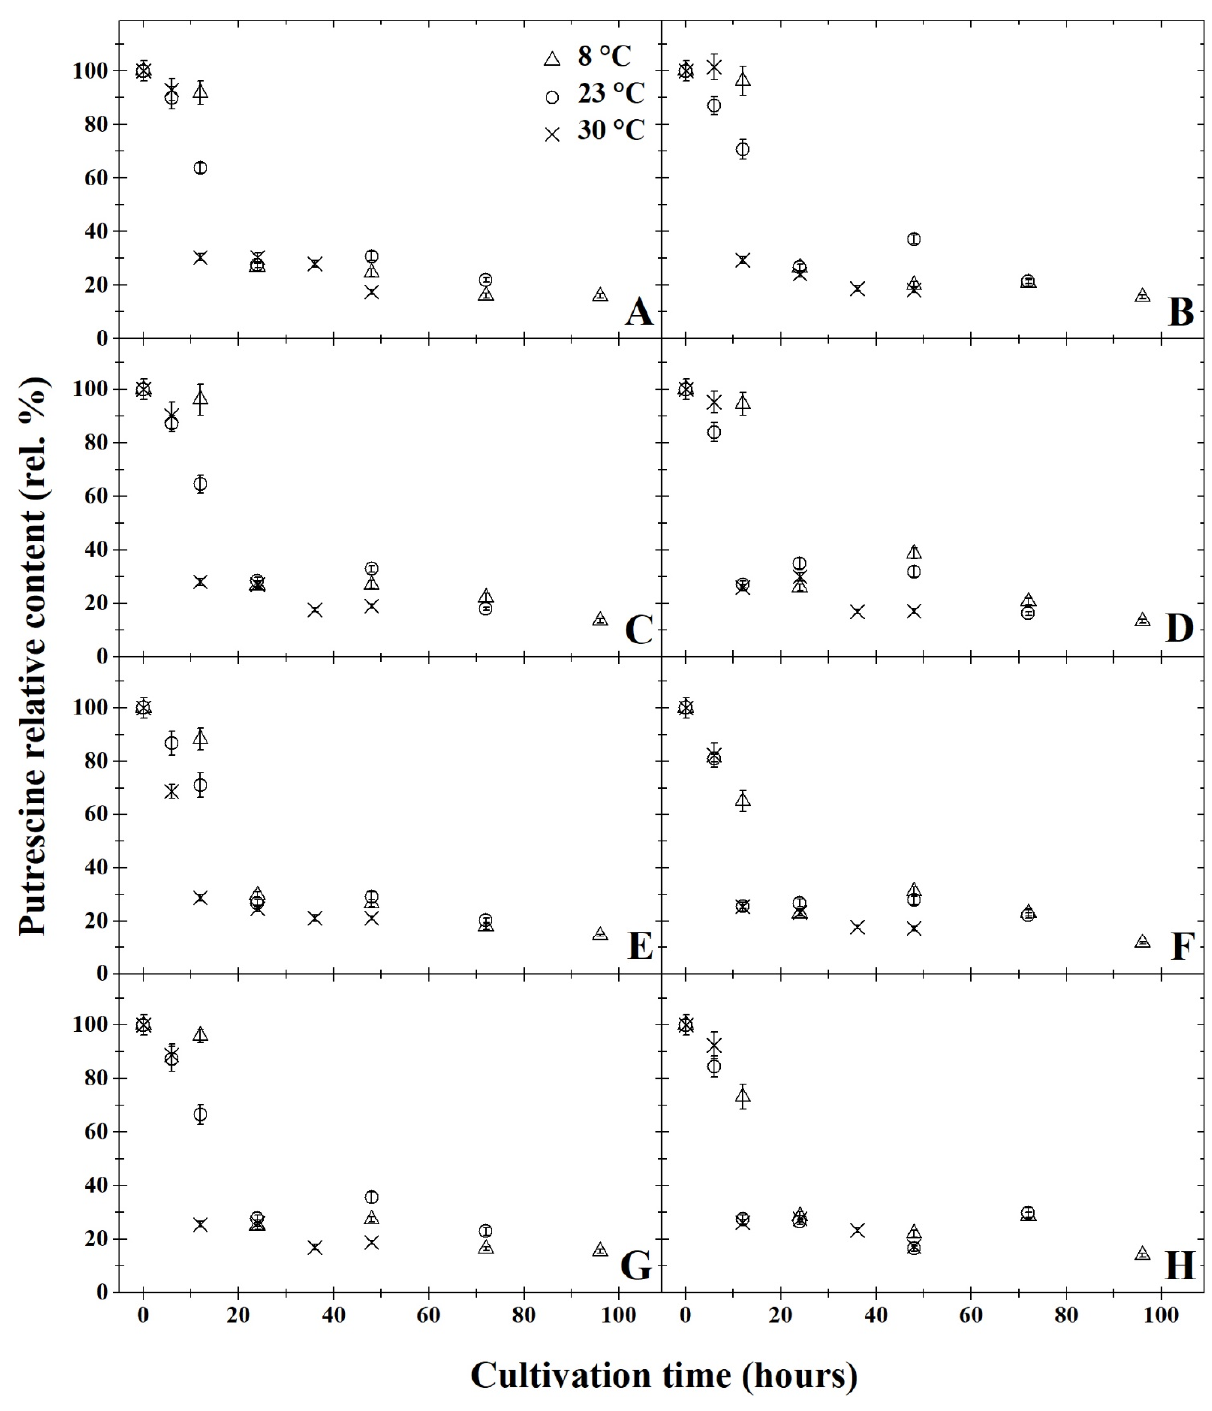
Figure 2. Development of putrescine relative content (rel. %) by degradation using Bacillus subtilis DEPE IB1 in dependence on the cultivation time (hours); the initial putrescine relative content at the time zero were always 100%. Parts ( A , C , E , G ) represent the results of anaerobic cultivation and parts ( B , D , F , H ) show the results of aerobic cultivation. Incubation was carried out under pH = 5 (parts A and B ), pH = 6 (parts C and D ), pH = 7 (parts E and F ), pH = 8 (parts G and H ). Three cultivation temperatures were used: 8 ◦ C ( (cid:52) ), 23 ◦ C ( ) and 30 ◦ C ( × ). The results were presented using the means and standard deviations (bars; n = 24).